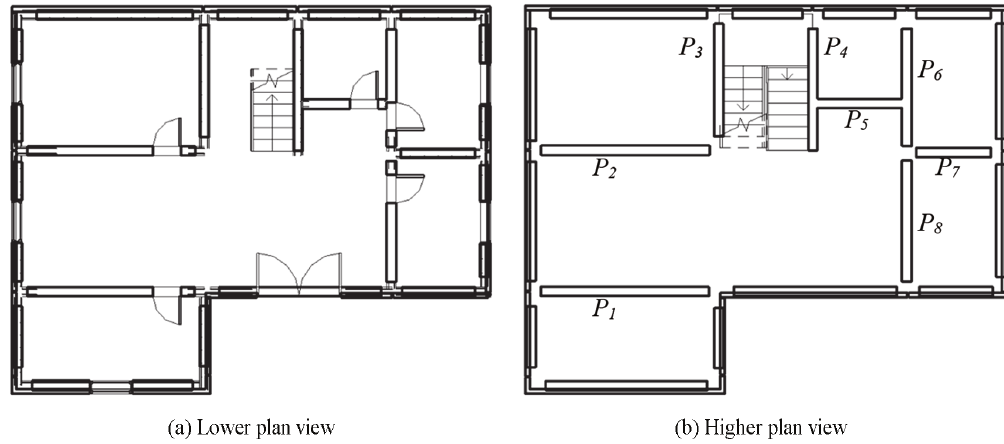
Figure 5. Plan views of a precast concrete building